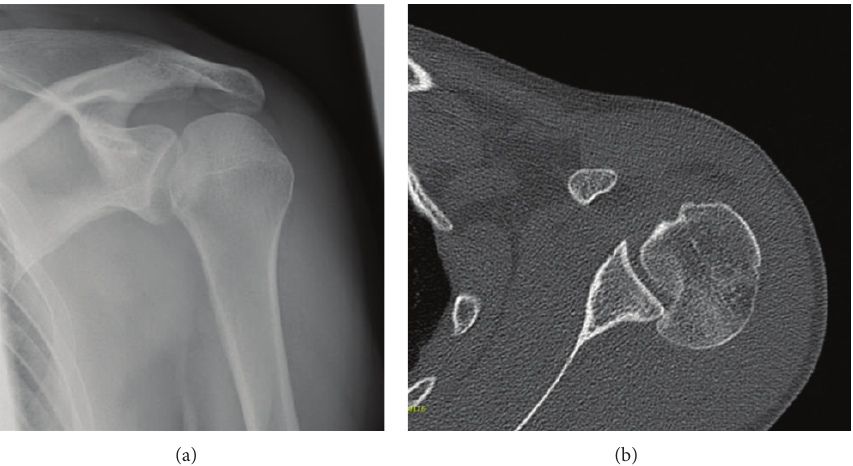
Figure 1: X-rays (a) and CT (b) showing the joint fixed in dorsal dislocation with the presence of a reversed Hill-Sachs defect.